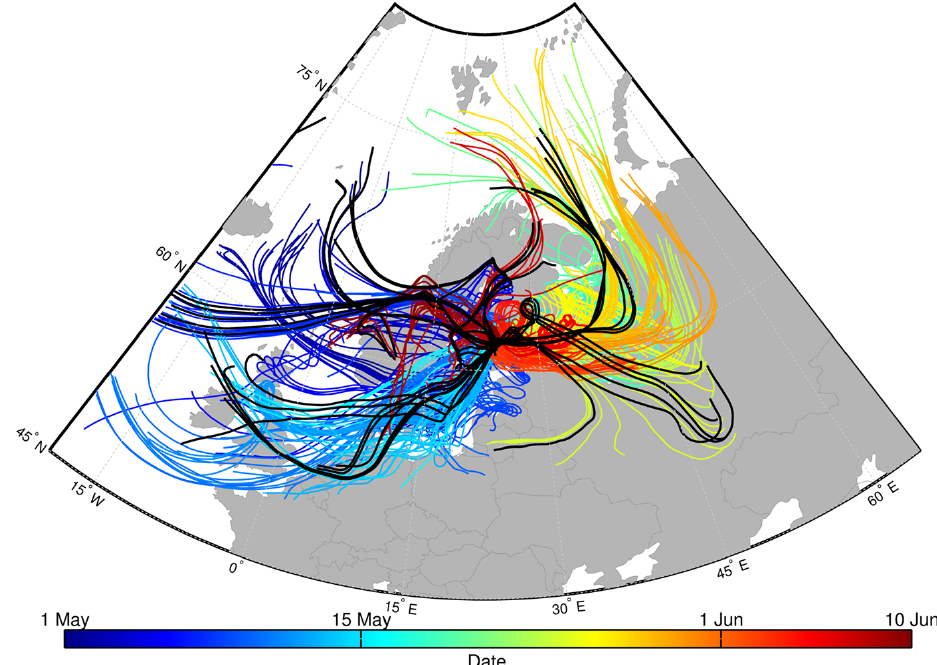
Figure 3. Air mass arrival trajectories to Hyytiälä 3 May–11 June 2013 calculated using HYSPLIT model. The colour indicates the arrival date and each trajectory represents air mass route during 96h before arrival. Air mass trajectories arriving on NPF days between 10:00–14:00 local time are marked with black lines.